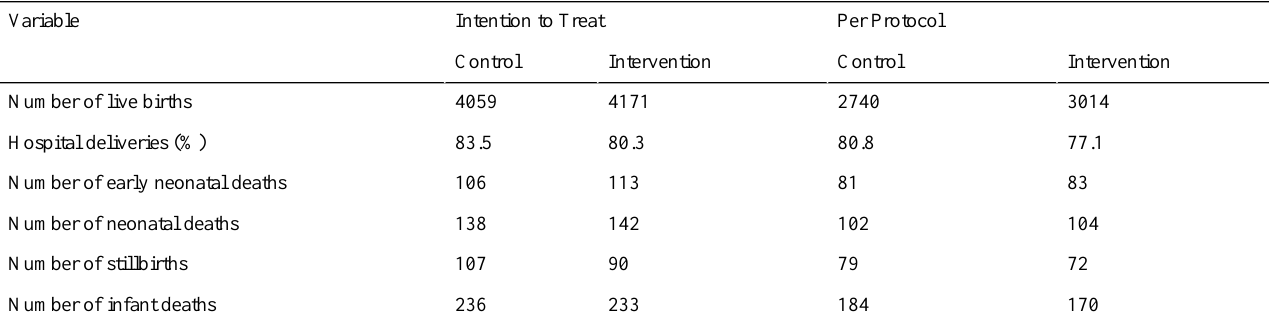
Table 2. Surveillance data on study outcome variables from February 2016 to January 2017.